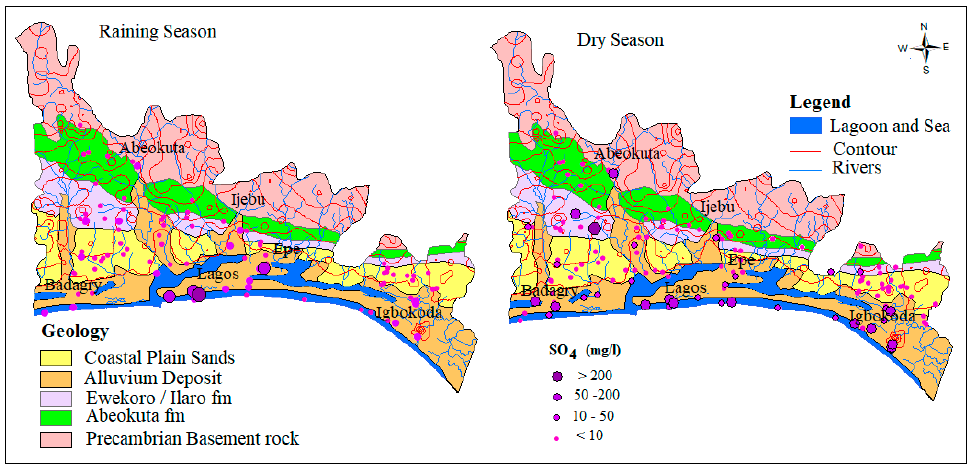
Cl 0.10 18970 SO 4 NO 3 0.02 259 32.2 0.3 Br 0.00 Fe Mn